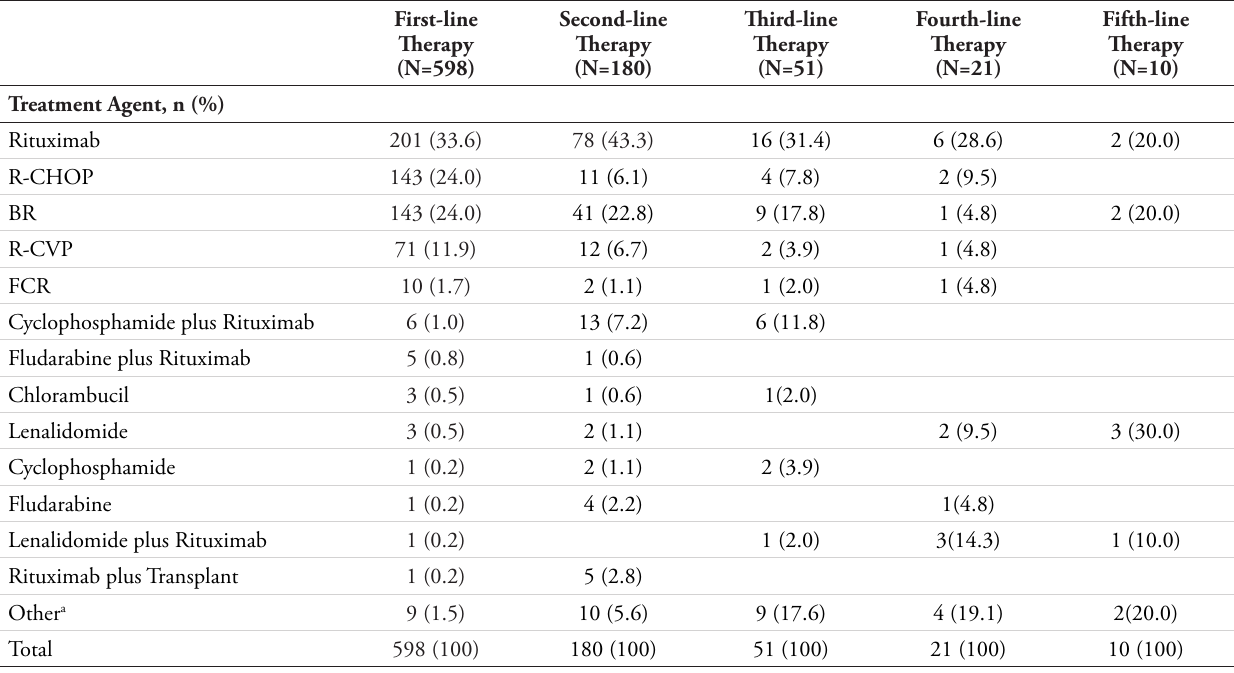
Table 3. Regimen Distribution by Line of